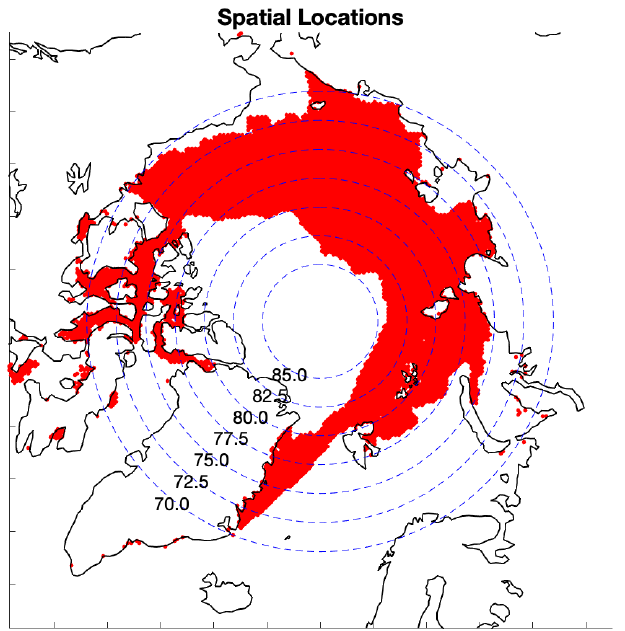
Figure 4. The spatial grid cells (in red) with at least one observed ice–water or water–ice transition from 2000 to